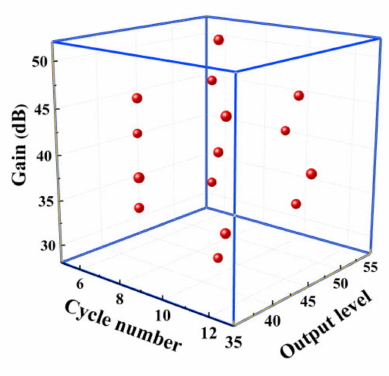
Figure 6. DOE space of the three design parameters and the selected training